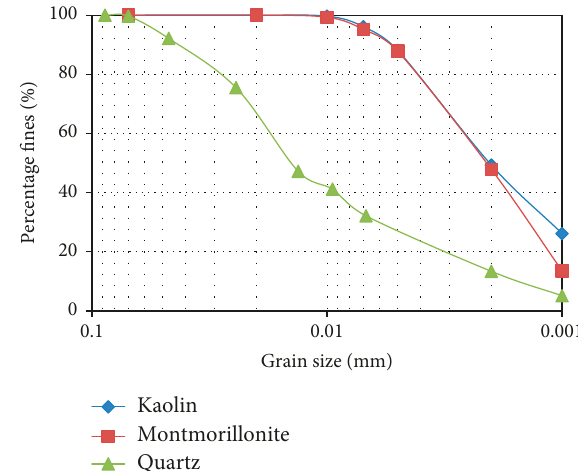
Figure 1: Grain size distribution of kaolin, montmorillonite, and